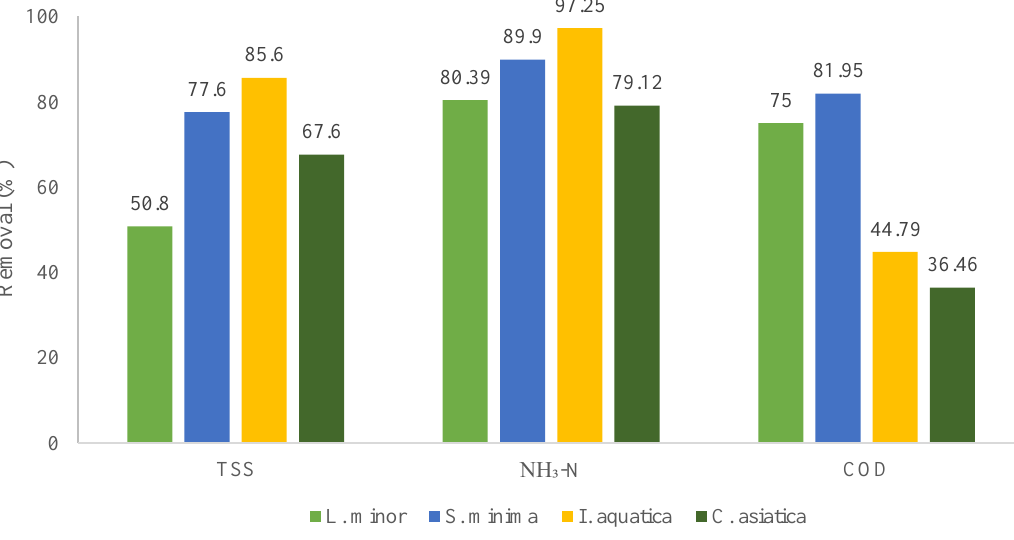
Figure 6. Percentage of reduction in TSS, NH 3 -N and COD for Lemna minor , Salvinia minima , Ipomoea aquatica and Centella asiatica .